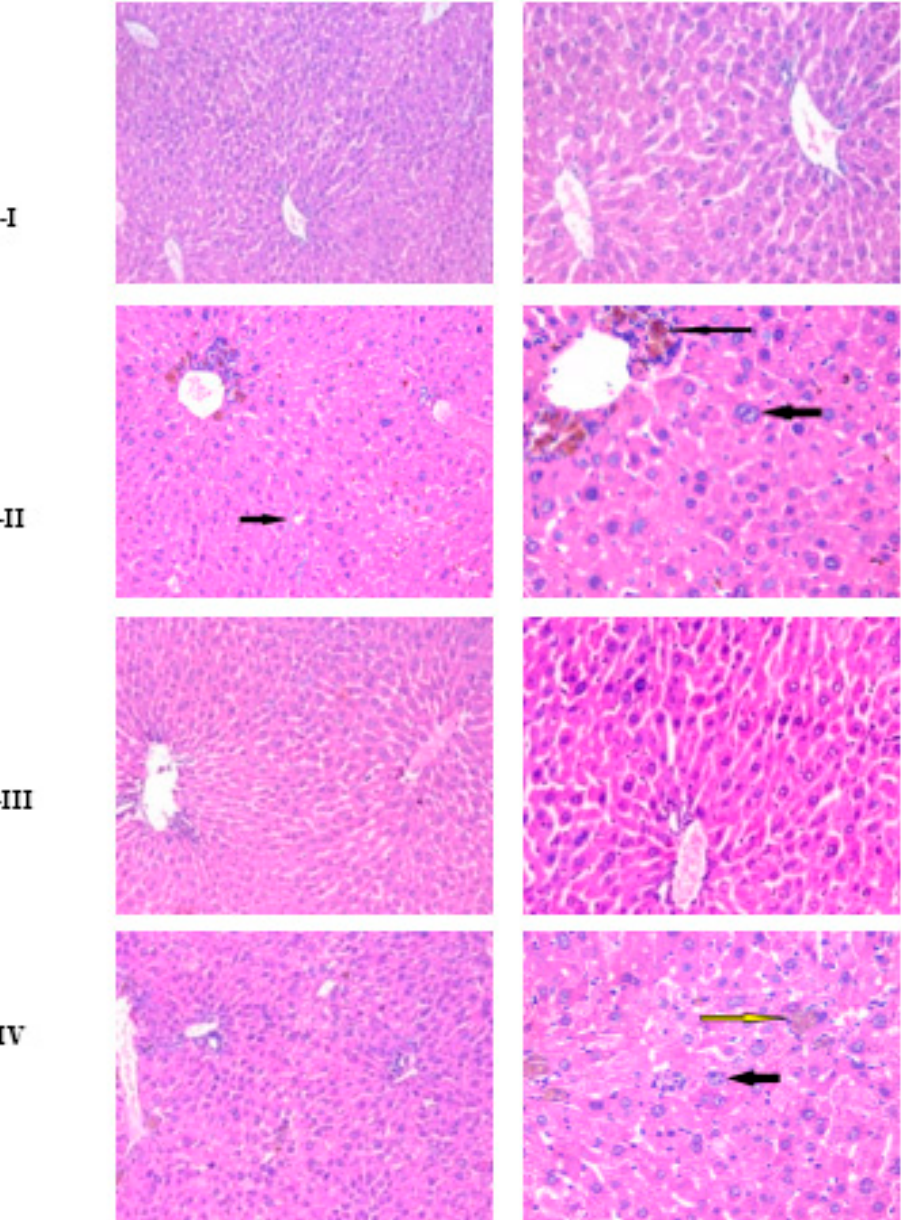
Figure 4. Histopathology using hematoxylin and eosin (H&E) staining of the liver, isolated from each animal group used in this study. For each group, the photo on the right side is a zoom-in taken from the photo on the left. Gp-I: Group I, normal group; Gp-II: Group II, treated with diethylnitrosamine; Gp-III: Group III, treated with A. gigantea ; Gp-IV: Group IV, treated with diethylnitrosamine combined with plant extract. Thick and thin black arrows in Gp-II indicate HCC with focal acinar formation and bizarre-shaped hyperchromatic nuclei and focal cholestasis, respectively. Thin yellow and black arrows in Gp-IV indicate focal hepatocellular dysplasia with focal cholestasis and few apoptotic figures, respectively.